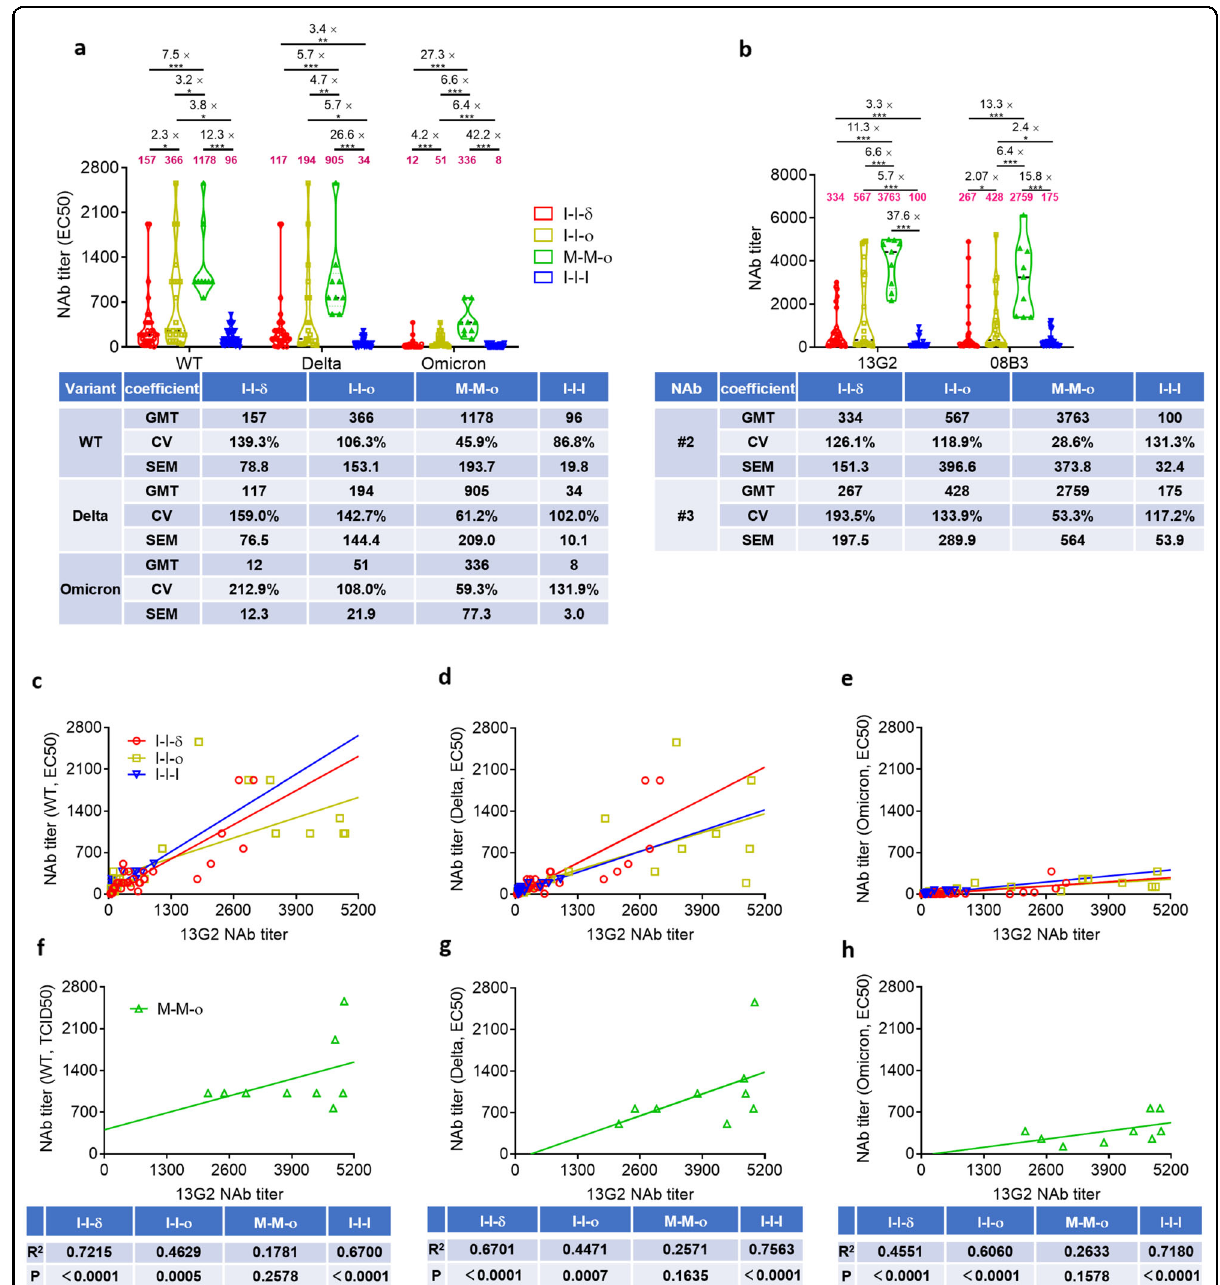
Fig. 1 Comparison of neutralizing activity among I-I- δ , I-I- ο , M-M- ο , and I-I-I groups. a Neutralizing response against WT SARS-CoV-2 and VOCs, including Delta and Omicron variants. The numbers in magenta indicated the geometric mean titers (GMTs), and fold change in GMT for the virus compared with the strain with lower neutralizing titer. b Comparison of NAb titers based on the monoclonal antibodies 13G2 and 08B3 among I-I- δ , I-I- ο , M-M- ο , and I-I-I groups. c – h Correlation of NAbs against the WT and the Delta and Omicron variants and levels of the monoclonal antibody 13G2 among I-I- δ , I-I- ο , M-M- ο and I-I-I groups. Signi fi cance was measured using the Mann – Whitney tests. * P < 0.05, ** P < 0.01, *** P < 0.001. I-I- δ , Delta infection after two-dose inactivated vaccine ( n = 34); I-I-o, Omicron infection after two-dose inactivated vaccine ( n = 22); M-M-o, Omicron infection after two-dose mRNA vaccination ( n = 9); I-I-I, three-dose inactivated vaccine ( n =